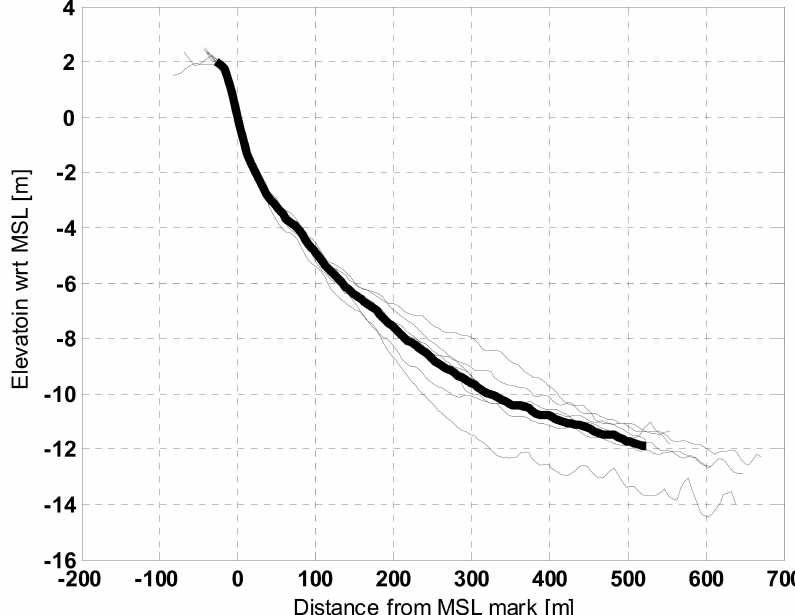
Figure 3. Measured beach Profiles (thin) and computed coastal cell-averaged beach profile (thick) for Coastal cell B-IV (Kalmunai to Karaitivu coastline